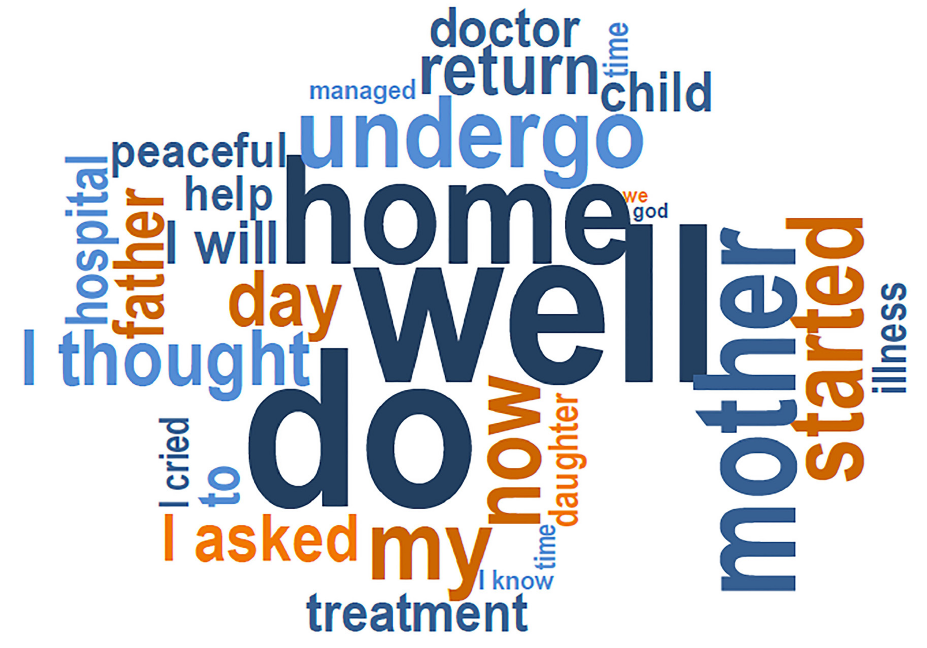
Figure 3. Word cloud generated from the transcript of the interviews with the parents, using the NVivo software. (*) Translator’s note: the word clouds were generated from the transcript of the interviews in Portuguese and translated to English keeping the original layout. Verbs in Portuguese are inflected differently for each grammatical person, so the use of a pronoun is necessary to keep their accurate meaning in English.